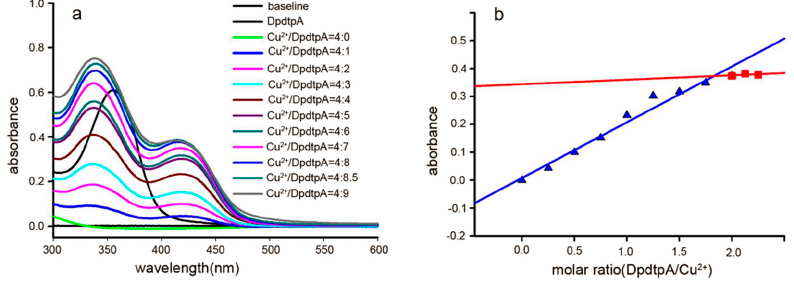
Figure 3. UV-visible spectra of DpdtpA copper complex and the relation between the absorbance and the molar ratio. ( a ) Spectra of CuCl 2 alone and in the presence of various concentrations of DpdtpA; the molar ratio is indicated in the figure; ( b ) Plot of the absorbance of the copper complex at 420 nm vs. the molar ratio of DpdtpA:Cu 2+ , a 2:1 ratio. The red line was regressive line of molar ration below 2 and the blue was regressive line of molar ration over 2.